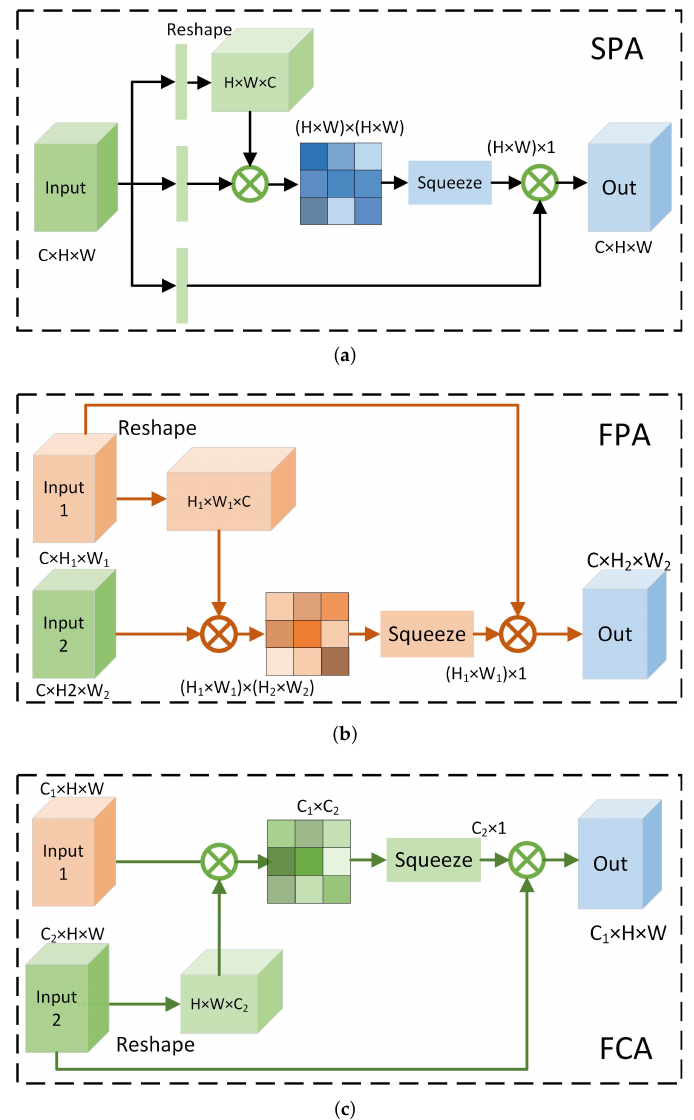
Figure 3. Position-channel collaborative attention module. ( a ) SPA. ( b ) FPA. ( c )